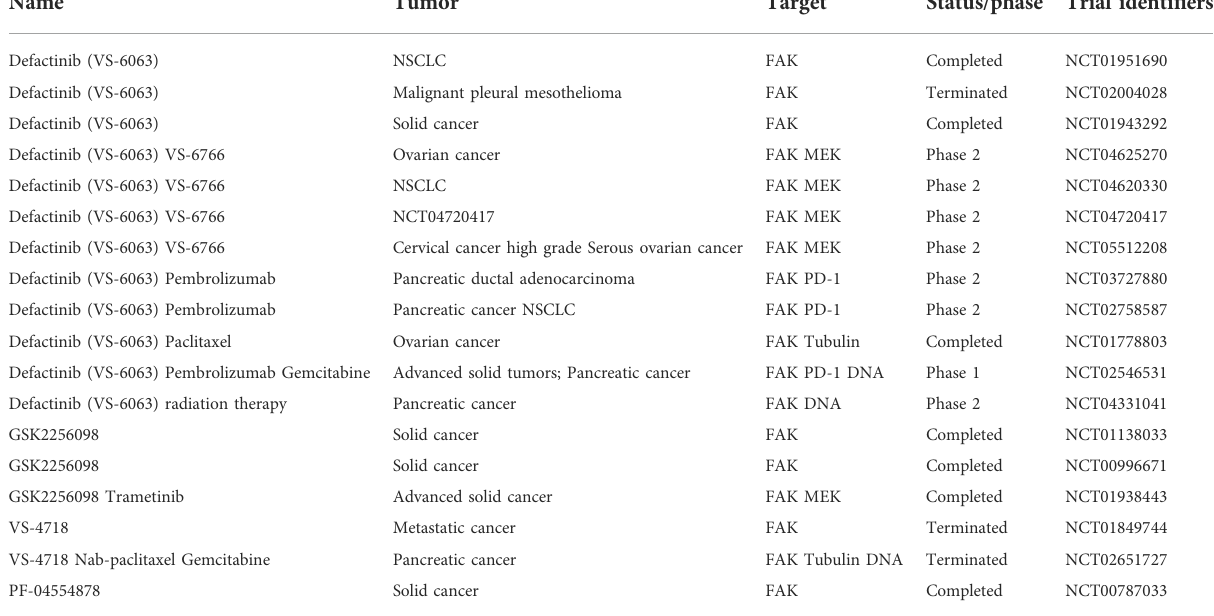
TABLE 3 Summary of clinical trials with FAK